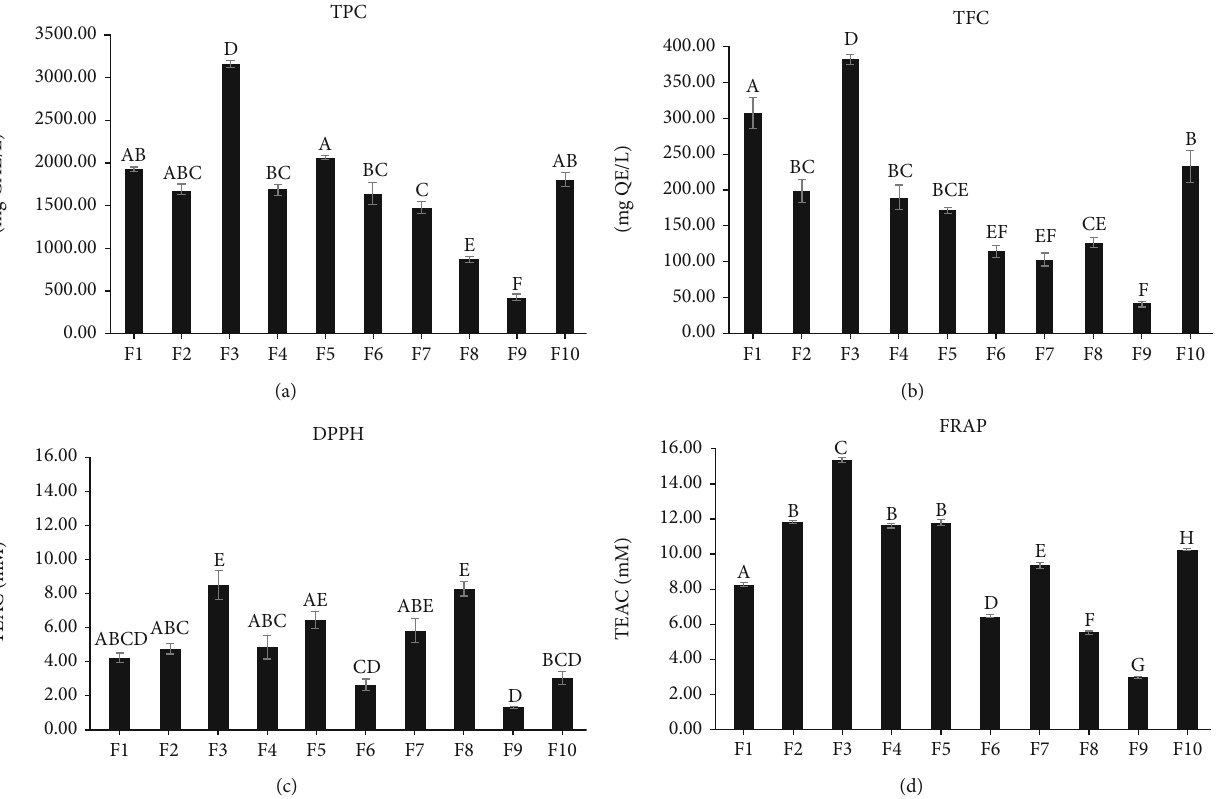
Figure 4: Antioxidant activity assay, total polyphenol content (a), total fl avonoid content (b), DPPH (c), and FRAP (d) of herbal infusions prepared with cocoa bean shell, I. guayusa and V. patens. Values are expressed as mean ± SD . The same letter indicates values that are not signi fi cantly di ff erent by Tukey test at p < 0 : 05